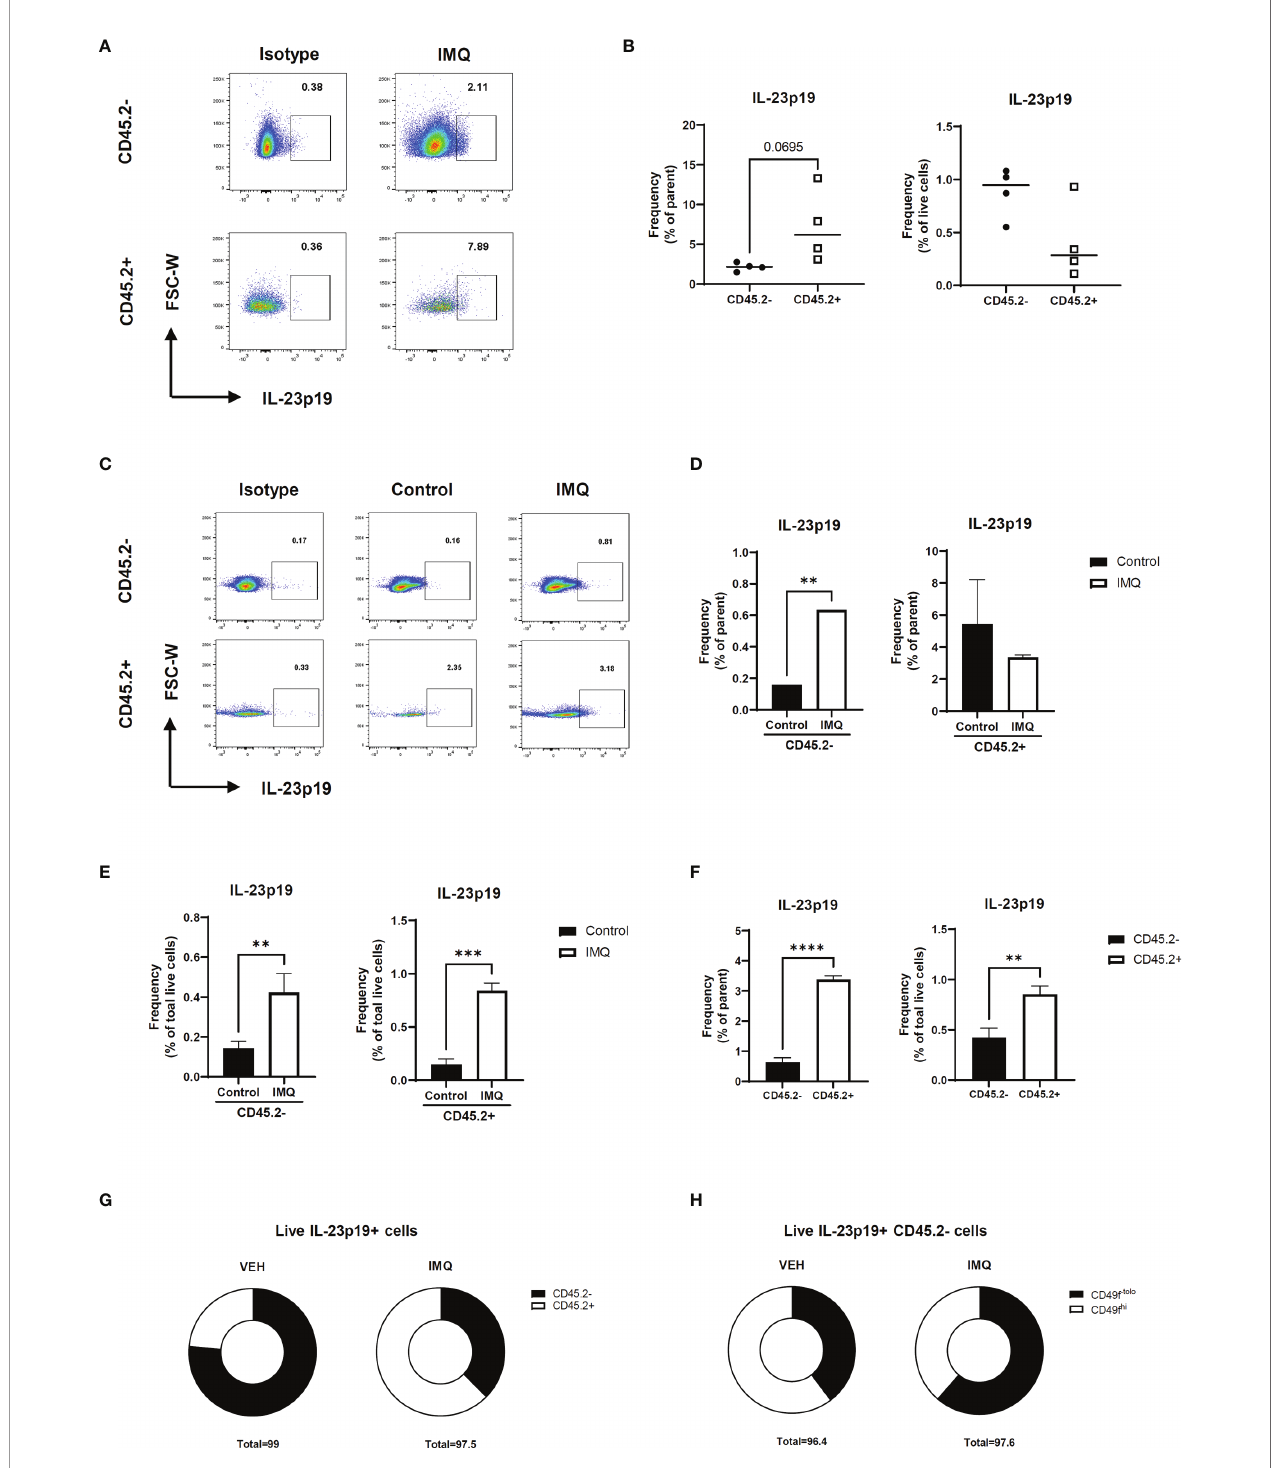
FIGURE 2 | IL-23 production in the keratinocytes of imiquimod-treated mice. (A, B) Representative fl ow cytometry plot (A) and graph (B) showing the frequency of IL- 23p19+ cells in imiquimod-treated mice skin. (C – E) Representative fl ow cytometry plot (C) and graphs (D, E) showing the frequency of IL-23p19+ cells in imiquimod- treated mice epidermis. (F, G) Bar graphs (F) and pie charts (G) showing the proportion of IL-23p19+ cells in CD45.2- and CD45.2+ cells of the epidermis. (H) Percentage of CD49 -tolo cells and Cd49 hi cells in live IL-23p19+ Cd45.2 - cells. Data are expressed as means ± SD. Lines above bars indicate statistical comparisons with signi fi cant differences between categories (** P < 0.01; *** P < 0.001; ****, P < 0.0001). Data represent two independent